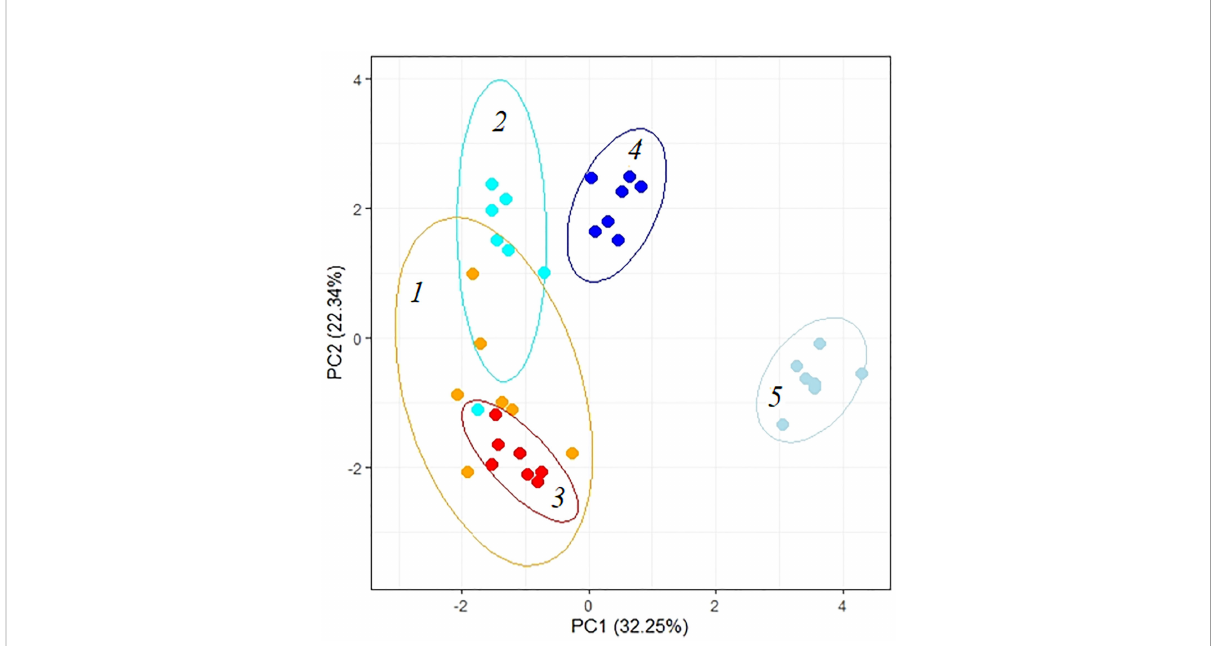
FIGURE 8 Principle component analysis (PCA) of the physiological data of Kochia prostrata on the fourth and 10th days of low (100 mM NaCl) and moderate (200 mM NaCl) salinity. 1 , Control; 2 , 4 days of 100 mM NaCl treatment; 3 , 4 days of 200 mM NaCl treatment; 4 , 10 days of 100 mM NaCl treatment; 5 , 10 days of 200 mM NaCl treatment. Parameters abbreviations are listed in Table